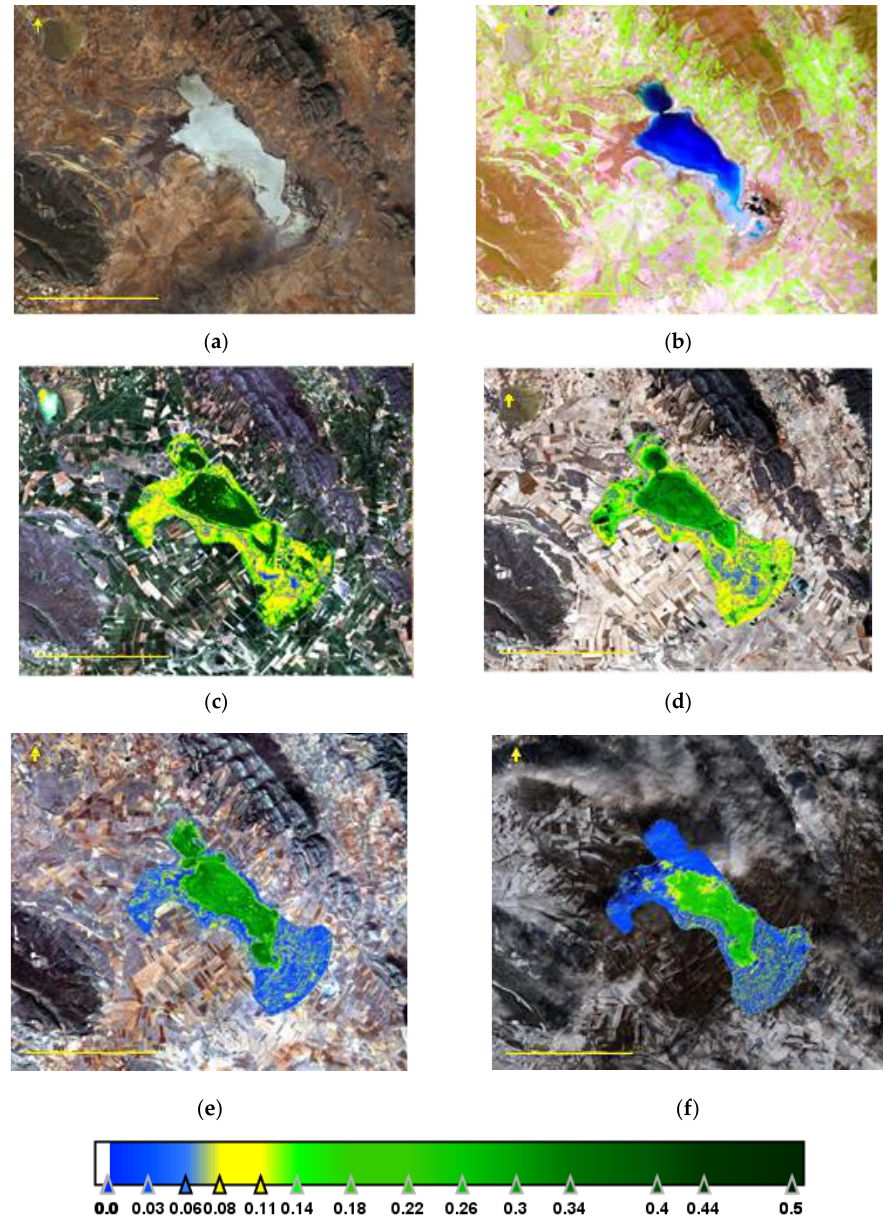
Figure 5. Different views of Gallocanta Lake in Sentinel-2 images during the study period. ( a , b ) images without vegetation in RGB natural false color. ( a ) 1 January 2018: Dry lake. ( b ) 19 April 2018: Lake newly inundated by snowmelt and runoff. ( c ) 29 April 2019: vegetation in spring. ( d ) 28 July 2019: vegetation during summer. ( e ) 11 November 2020: vegetation in autumn period. ( f ) 5 January 2021: the lake during snowfall and freezing period. Lower legend vegetation index NDI45. Scale bar 5 km.